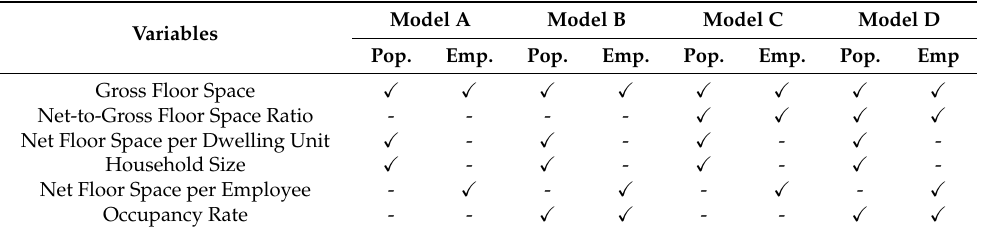
Table 1. Different combinations of variables used for experimenting building floor space in the station area population and employment